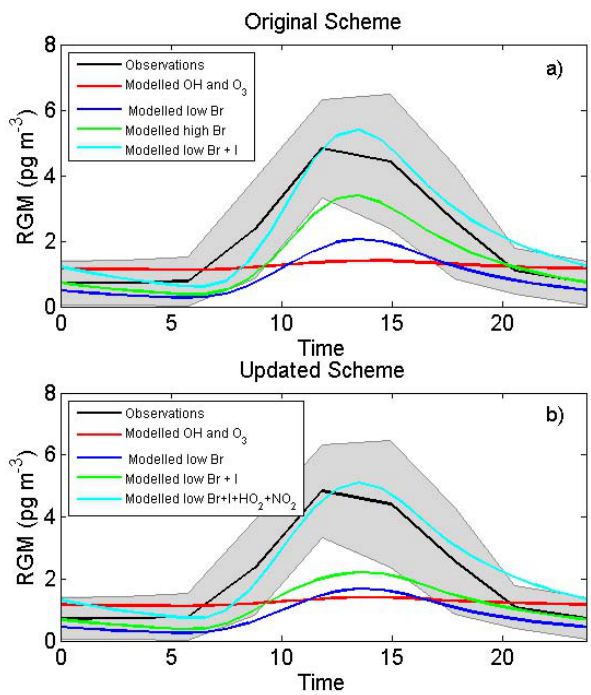
Fig. 6. Comparison of the average daily profile of reactive gaseous mercury (RGM) during October (grey area indicates the standard deviation of the data) with simulated profiles obtained by two dif- ferent modelling approaches. (a) Modelled results from the original chemistry scheme according to Goodsite et al. (2004) and Holmes et al. (2009) under four different scenarios. Scenario 1: oxidation is assumed to result only from OH and O 3 (red line). Scenario 2 adds bromine oxidation using a peak BrO of 0.2pptv (blue). Sce- nario 3 (green) assumes BrO to be at the detection limit of the DOAS instrument (0.5pptv). Scenario 4 (cyan) shows a simulation with 0.2pptv of BrO and the observed levels of IO, an average of 1pptv during the daytime. (b) Modelled results using an updated chemistry scheme according to Goodsite et al. (2012) and Dibble et al. (2013). Peak daytime mixing ratios of the bonding molecules were OH = 0.14pptv, O 3 = 10ppbv, Br = 0.08pptv, I = 0.45pptv, NO 2 = 40pptv, and HO 2 = 14pptv (see Fig. S1 for their diurnal